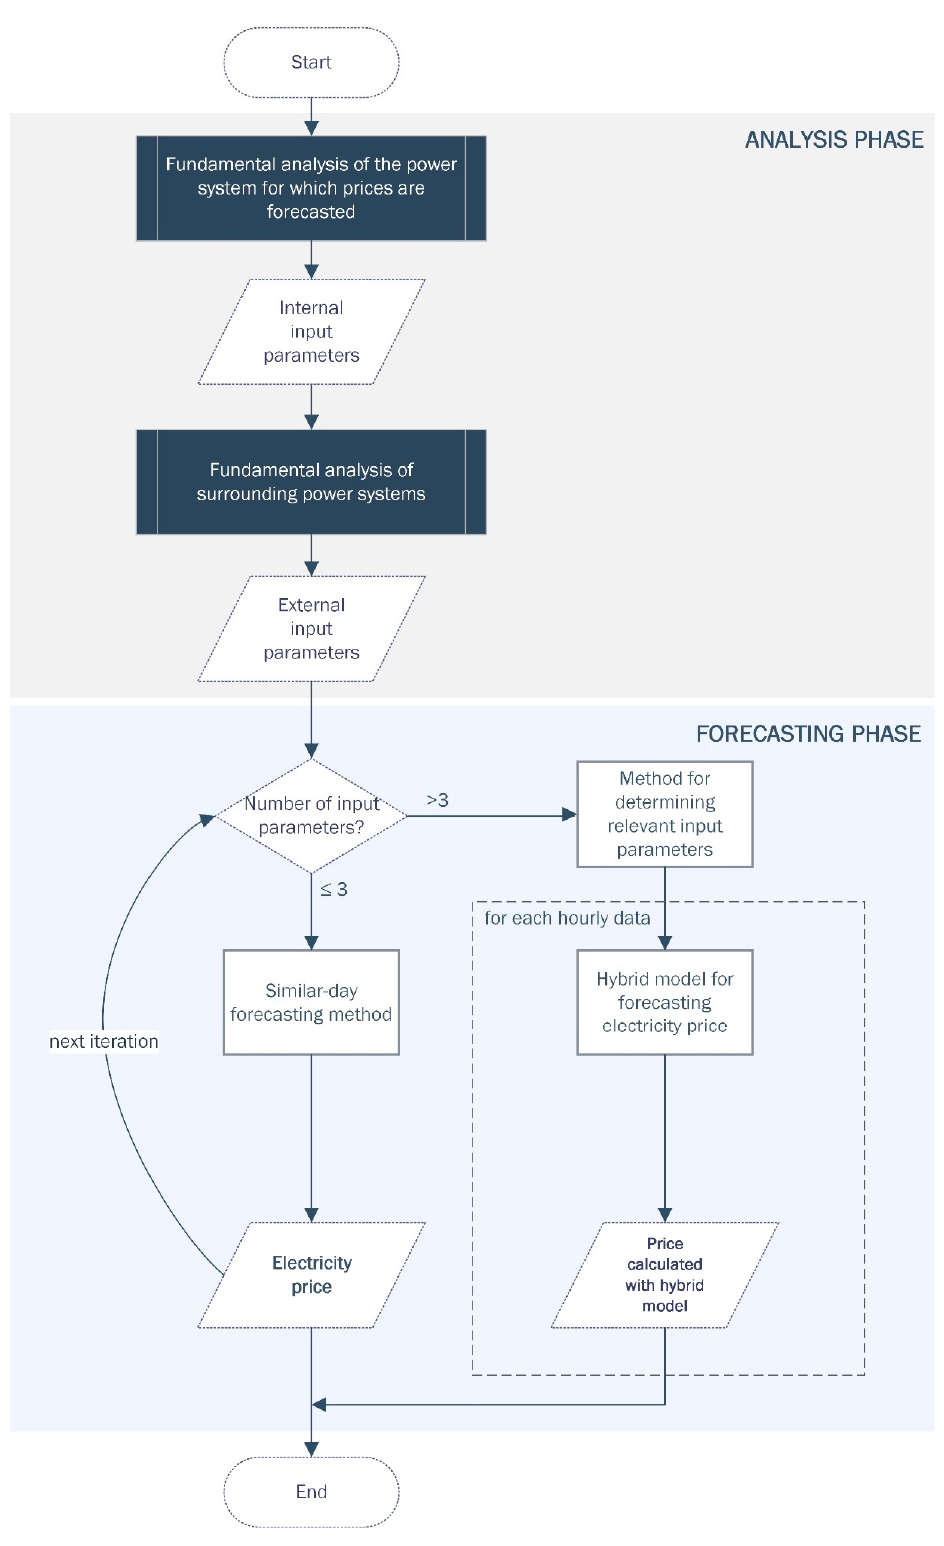
Figure 8. Flow chart of the Hybrid Iterative Reactive Adaptive (HIRA) method for electricity price forecasting.